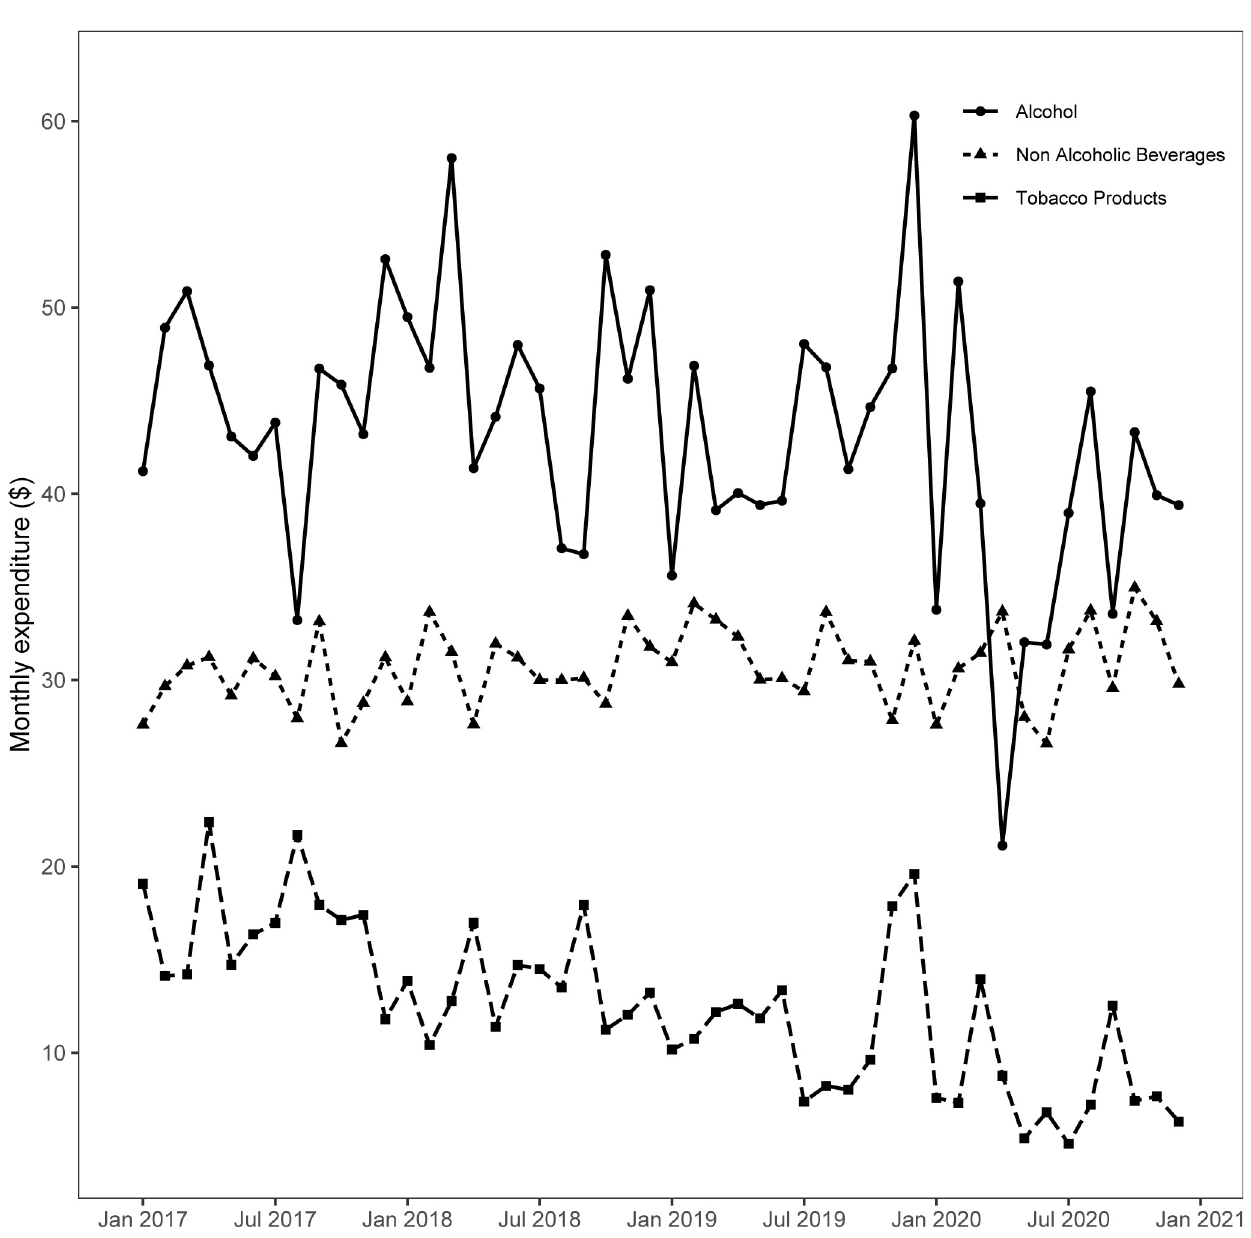
Fig 1. The trend of monthly household expenditure dollars on alcohol, non-alcoholic beverages, and tobacco products. estimate that a unit change (or compared to the reference group in the case of categorical pre- dictor) in the predictor variable is associated with ð e ^ b (cid:0) 1 Þ � 100% change in expenditure. The dummy variable denoting the pandemic versus pre-pandemic was significantly associated with the bi-weekly spending on alcohol, non-alcoholic beverage, or tobacco products. The association was much more prominent in the alcohol expenditure (estimate = -0.337, 95% CI: -0.409; -0.264), which corresponds to a decline of 28.6% (95% CI: 23.2%; 33.6%) during the pandemic period compared to the pre-pandemic period. The expenditure on tobacco products decreased by 15.5% (95% CI: 11.31%; 19.3%) during the pandemic period. In the case of non-